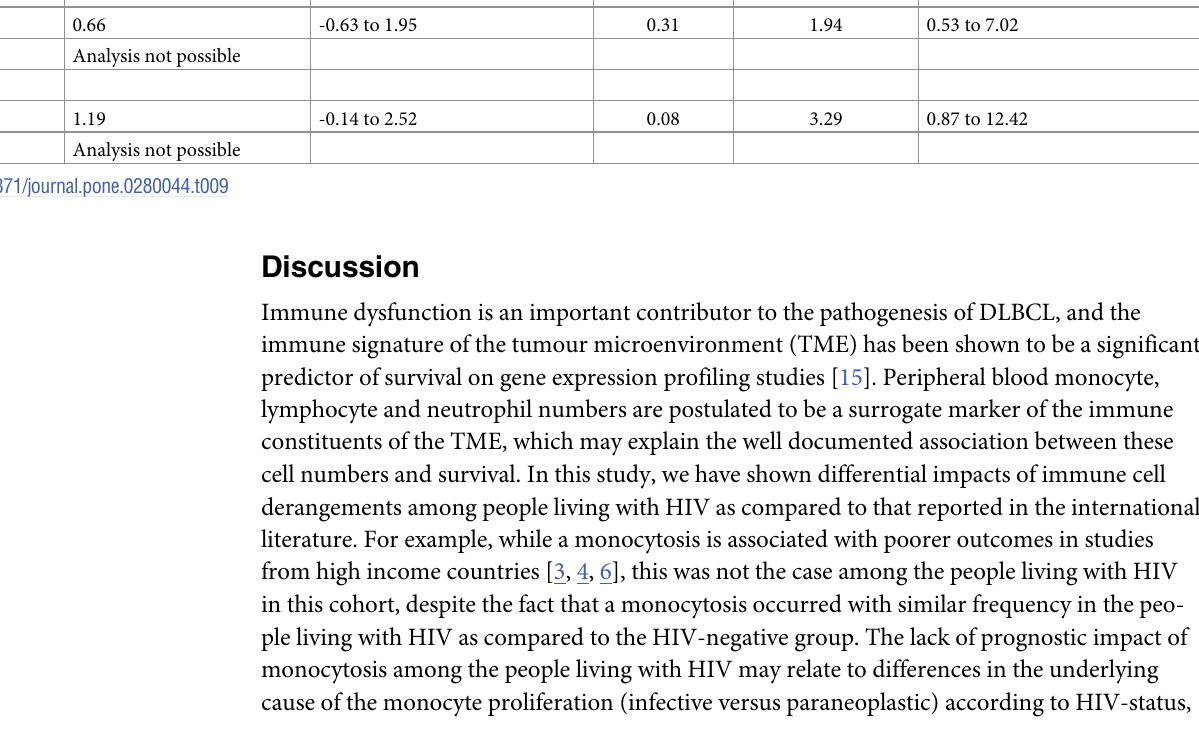
Table 10. Cox proportional-hazards regression analysis for independent associations between the survival time and the CD4 count and Treg expression of CD39.